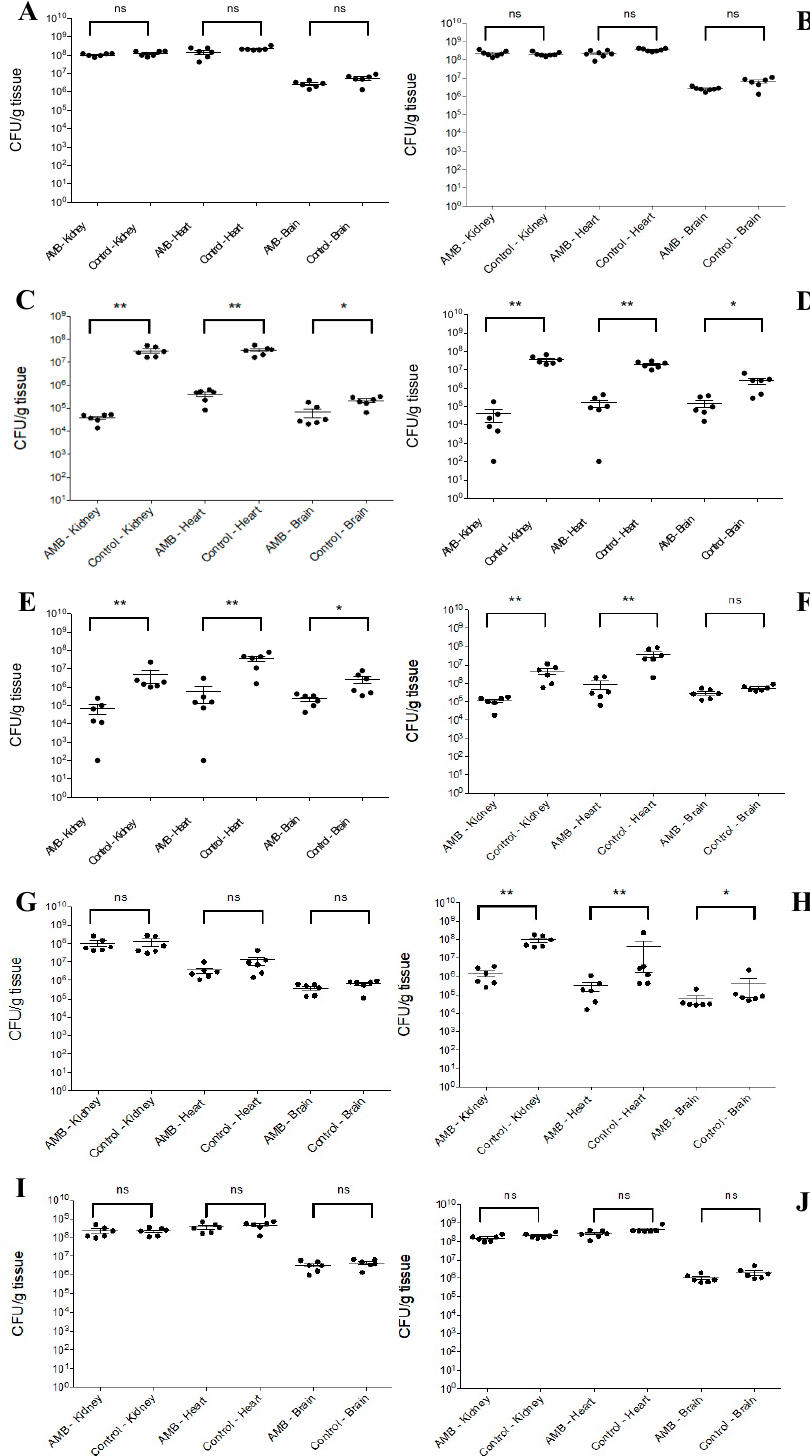
Figure 2. Fungal kidneys, heart and brain burdens were determined with 2-2 clinical isolates from the South Asian {isolates 27 ( A ) and 196 ( B )}, East Asian {isolates CBS 12,372 ( C ) and CBS 12,373 ( D )}, South African {isolates 2 ( E ) and 204 ( F )} and South American {isolates I-24 ( G ) and I-156 ( H )} clades at day 6. Two environmental isolates CDC B-13108 ( I ) and CDC B-13112 ( J ) from the South American clade were also tested. The infectious dose was 8 × 10 6 CFU/mouse. Daily 1 mg/kg of amphotericin B (AMB) treatment began 24 h post-infection. The bars represent the medians. Level of statistical significance is indicated at p < 0.05 (*), p < 0.01 (**). NS corresponds to non-significant.